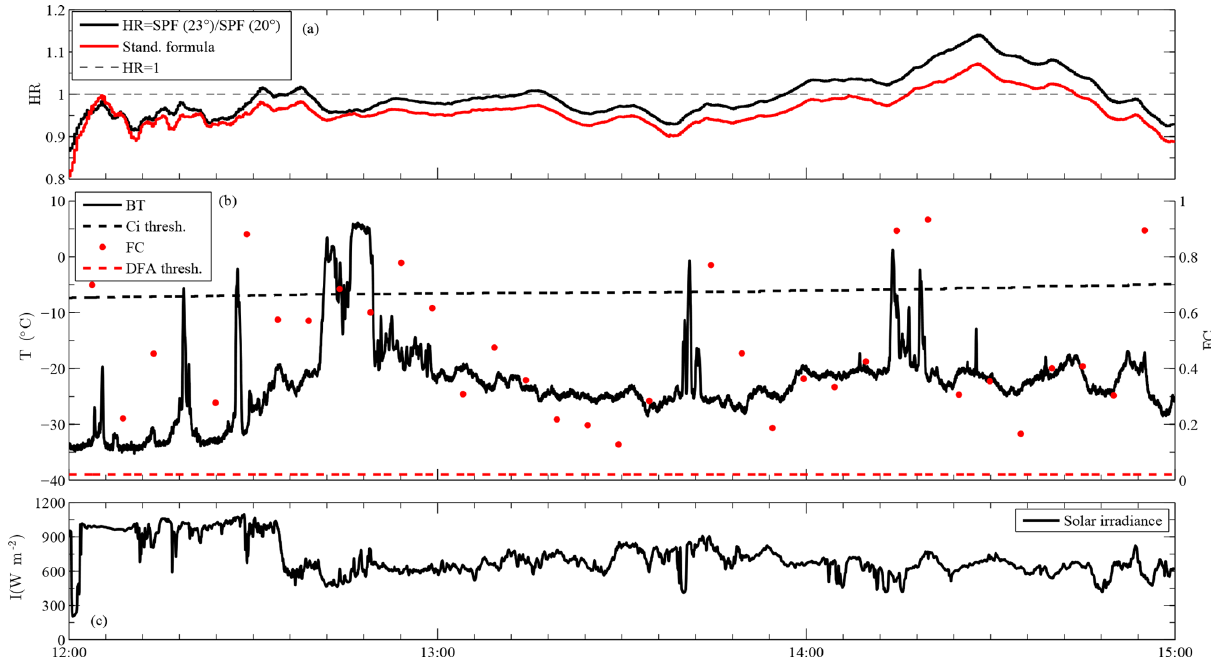
Figure 13. Time series from 7 July 2016 between 12:00 and 15:00. (a) HR (halo ratio), black line – new definition, red line – standard formula – (see text). (b) BT (brightness temperature) – black line, FC (fluctuation coefficient) – red dot, DFA (detrended fluctuation analysis) threshold – red dashed line, Ci (cirrus) threshold – black dashed line. (c) Solar